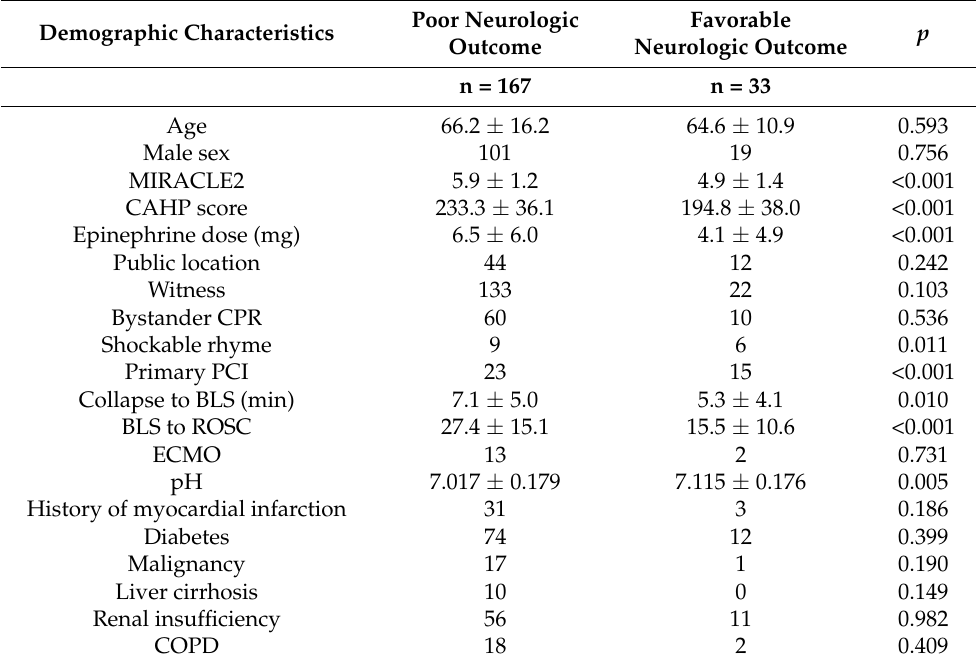
Table 1. Demographic characteristics, pre-hospital factors, treatment in the ED, comorbidities, and calculated CAHP and MIRACLE2 scores of 200 OHCA patients with ROSC.